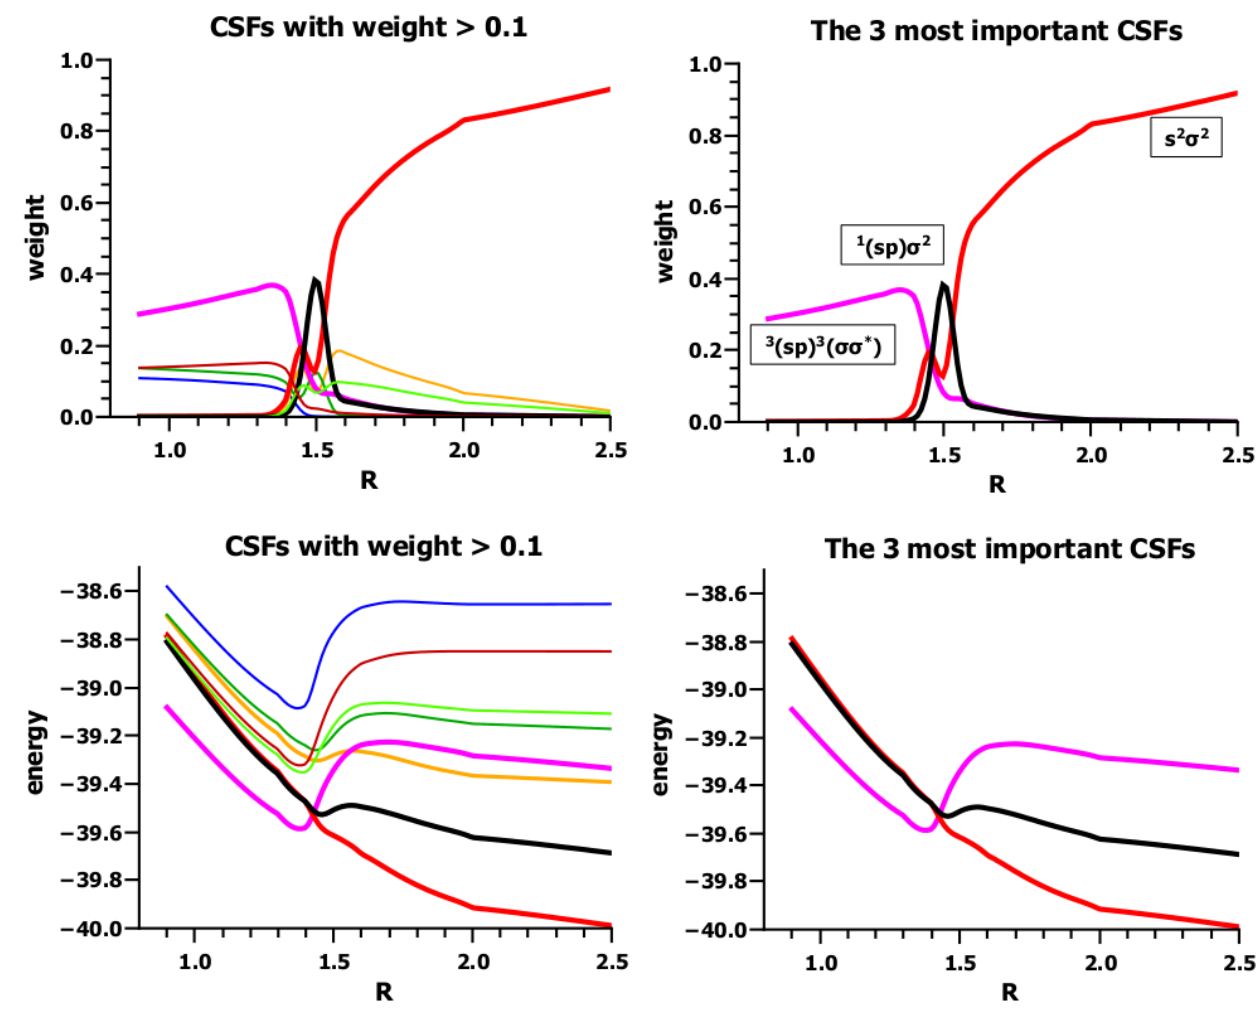
Figure 17. Carbene insertion into H (Left) Energies and weights of all FO-CSFs with 2 . weight larger than 0.1. (Right) Energy and weights of the three most important FO-CSFs. Energy in Hartrees; R in